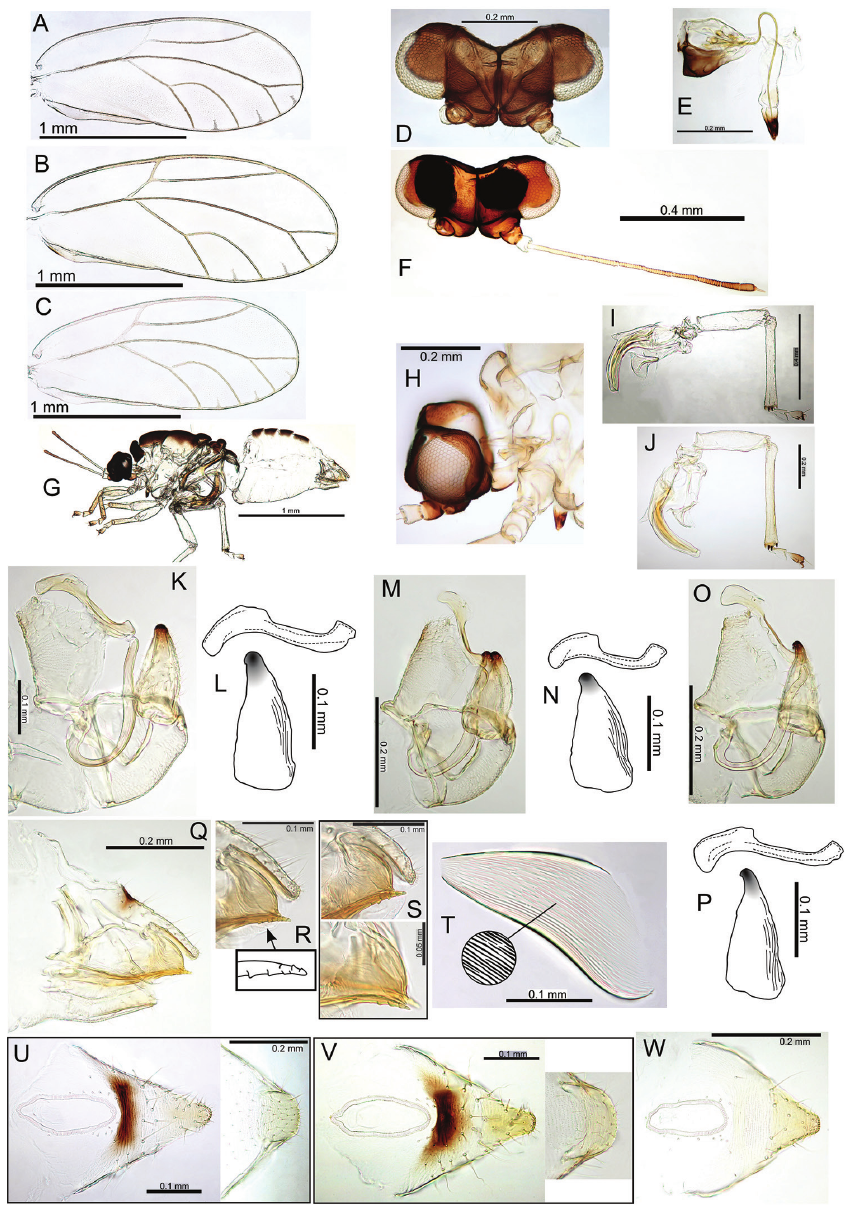
Figure 8. Pariaconus wyvernus sp. n. A, B, C fore wing: A form wyvernus B form chimera C form gor- gonus D, E head, proboscis, form wyvernus F head and antenna (uncleared ocular tissue), form chimera G female, form wyvernus H male head, form wyvernus I, J hind legs: I form wyvernus J form gorgonus K, L, M, N, O, P male terminalia, aedeagus and paramere: K, L form wyvernus M, N form chimera O, P form gorgonus Q female terminalia, form wyvernus R, S ovipositors: R form wyvernus (serrations indicated) S form gorgonus (above), form chimera (below) T egg (striations indicated), form wyvernus U, V, W female proctigers and subgential plates: U form wyvernus V form chimera W form